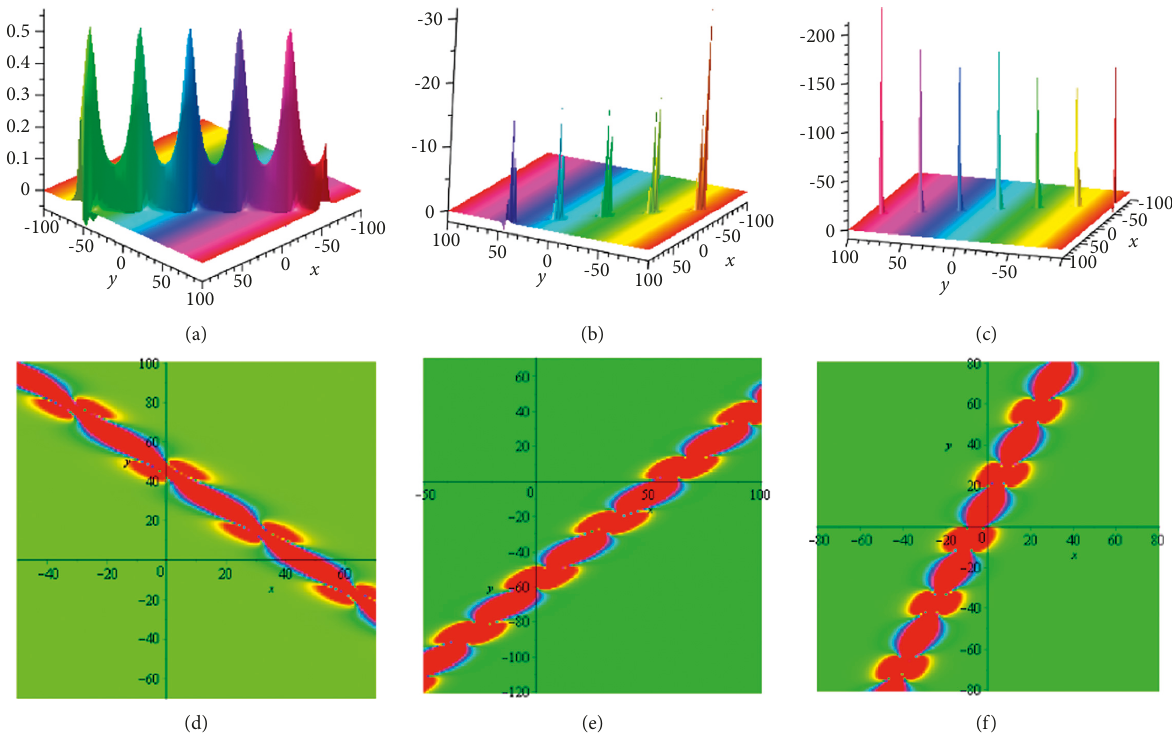
Figure 10: Plots of equation (55) by taking ϱ f 2. (c) f 3. (d) f 4. (e) f 5. (f) f 6.